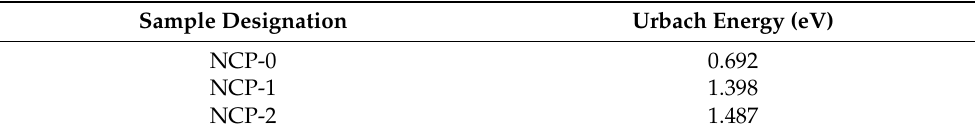
Table 3. Urbach energy for pure PEO and PEO doped solid polymer films.